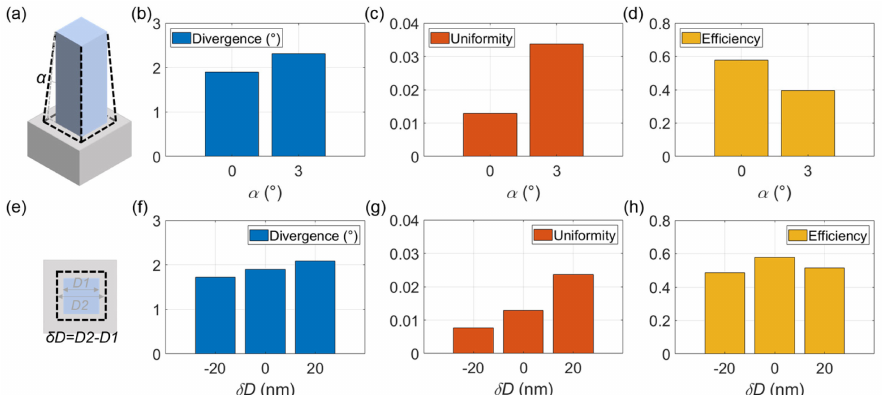
Figure 6. Influence of the fabrication error on the metasurface. ( a ) Sidewall angle variation and ( e ) diameter variation. Influences of the sidewall angle variation on ( b ) the divergence angle, ( c ) the uniformity and ( d ) the total diffraction efficiency, respectively. Influences of the diameter variation on ( f ) the divergence angle, ( g ) the uniformity and ( h ) the total diffraction efficiency,